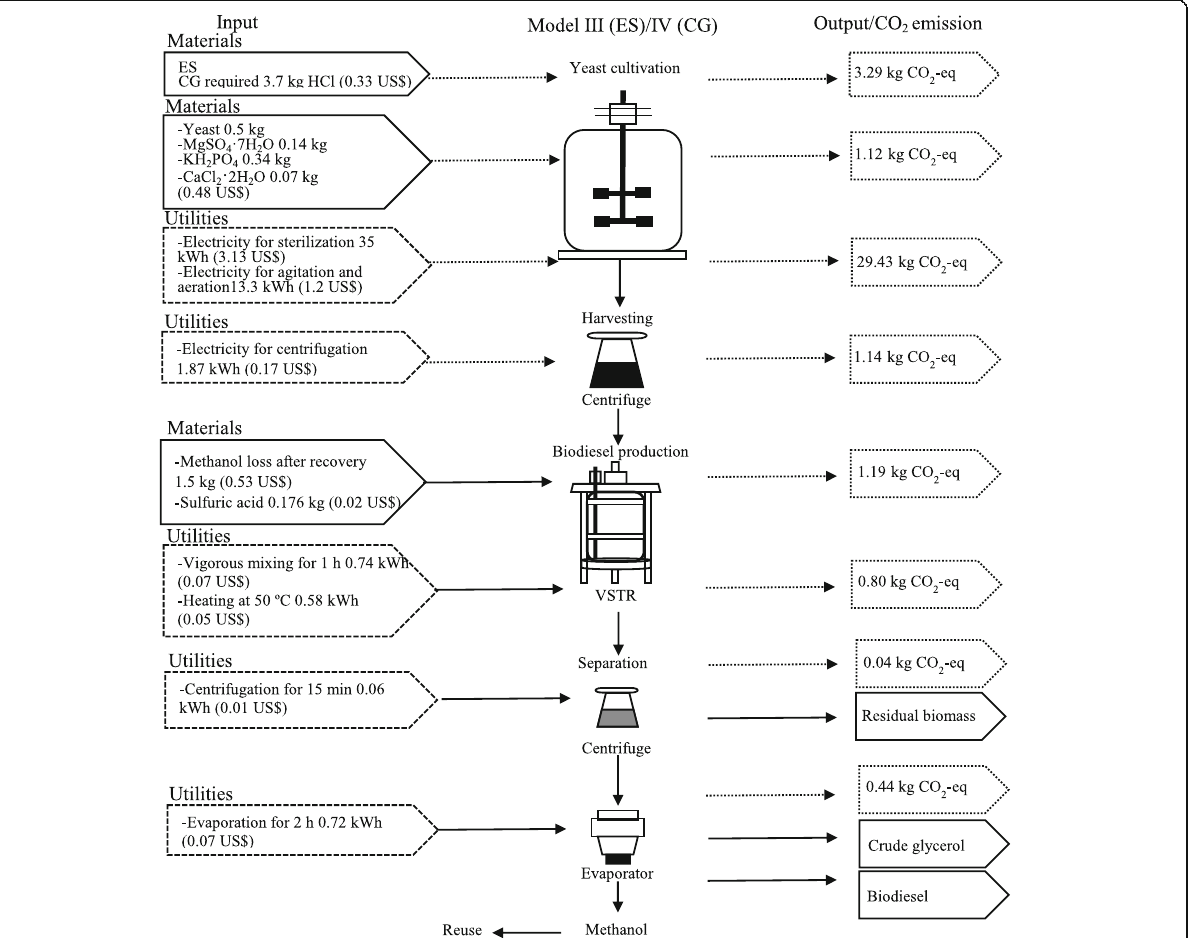
Fig. 3 Process flow for bioconversion of liquid wastes into lipids by appropriate oleaginous yeasts in 1 m 3 reactor scale and subsequent biodiesel production in 30 L VSTR